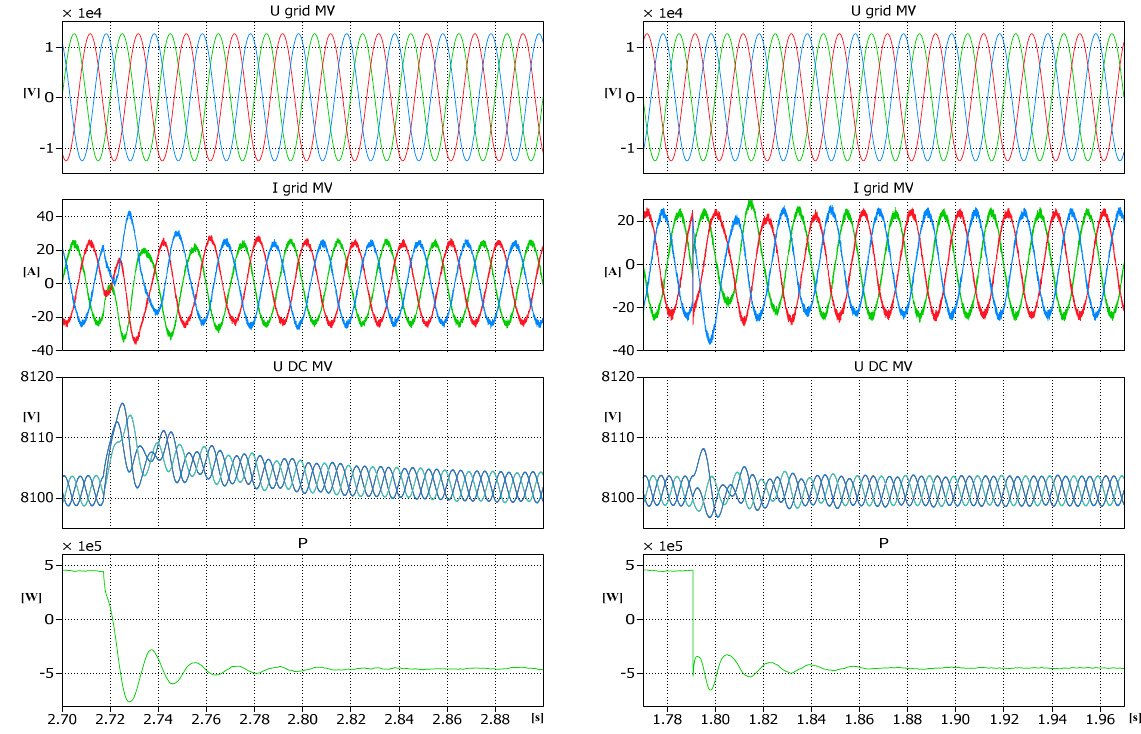
Figure 9. Steady-state operation at nominal power P AC , MV = 450 kW. From the top: grid line voltages u AC , x , grid line currents i AC , x , DC voltages U DC , xk , grid active power P AC , MV . In Figure 10, results for energy flow direction change are shown. Changes in active power change from nominal 450 kW transferred from MV-AC grid to DC currents sources to 450 kW in the opposite direction using the system without and with PFF are simulated. In both cases, grid currents are sinusoidal, and DC voltages are balanced. After implementing PFF (on the right), DC voltage transient is much shorter, and line currents peak transient values and grid active power oscillation are reduced.